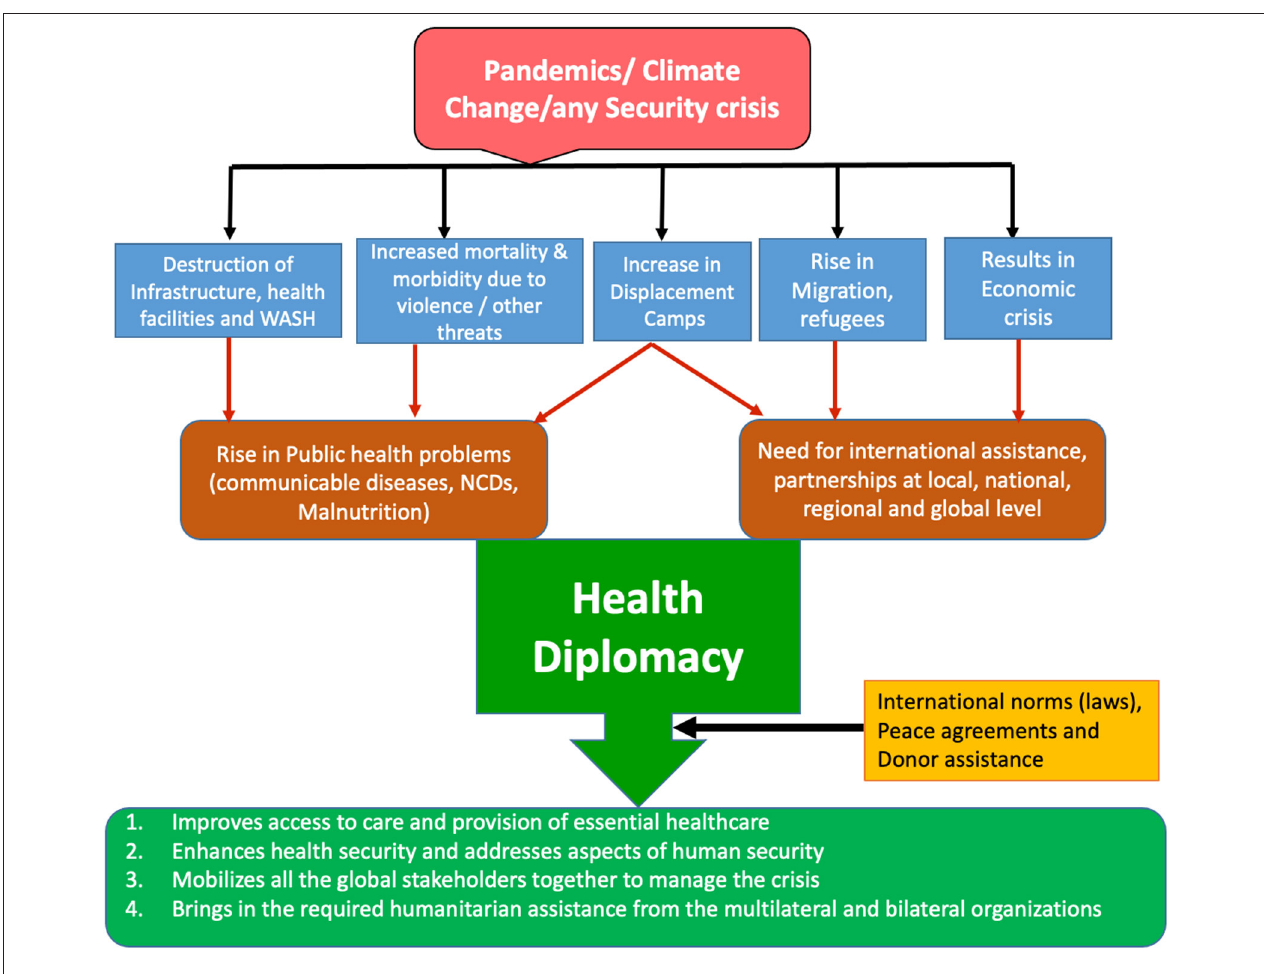
FIGURE 1 | Addressing global health threats and crises through health diplomacy. Source: Prepared by the